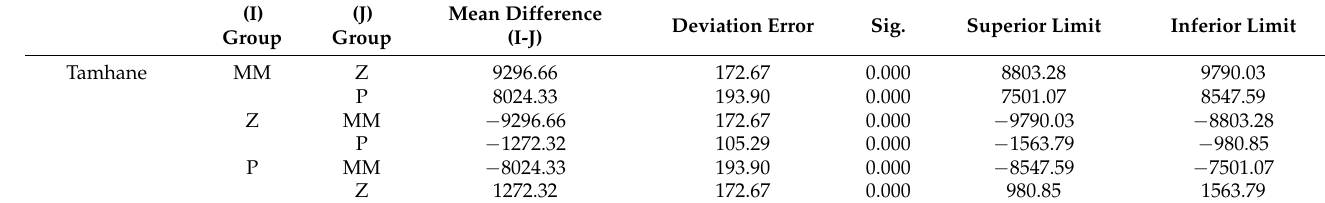
Table 2. Tamhane post hoc test. (MM: milled metal; Z: zirconia; P: PEEK).